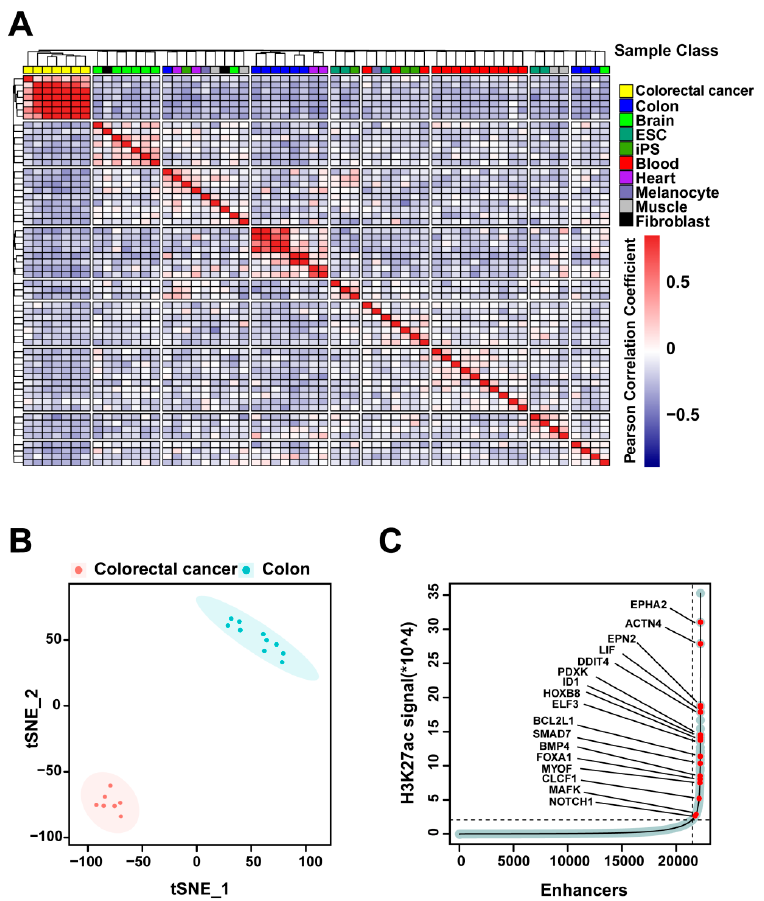
Figure 2. H3K27ac profiles define colorectal-cancer-specific enhancers. ( A ) The unsupervised hierarchical clustering of the 11,463 enhancer loci detected in colorectal-cancer samples ( n = 7) compared to that of normal tissue samples ( n = 10). ( B ) t -distributed stochastic neighbor embedding ( t -SNE) analysis of normal colon-tissue-specific enhancers (Colon) and colorectal-cancer-specific enhancers. t -SNE_1 p = 2.03 × 10 − 15 , t -SNE_2 p = 8.54 × 10 − 12 . ( C ) Inflection plot showing the identified super enhancers among the cancer-specific